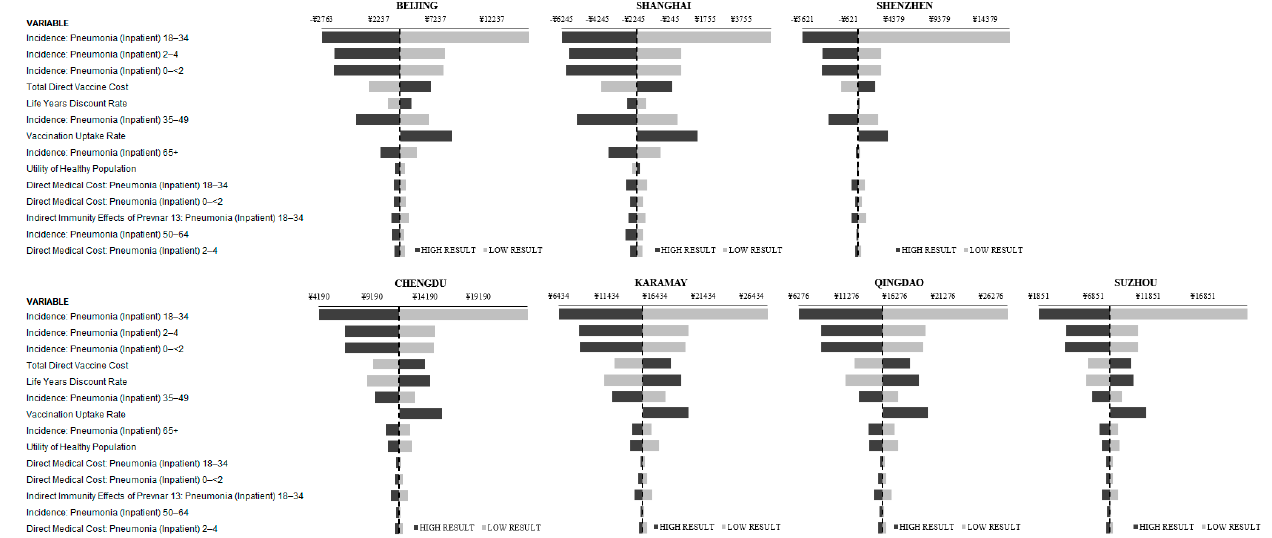
Figure 2. IDE + DE: One-Way Sensitivity Analysis Results (Tornado Diagrams).